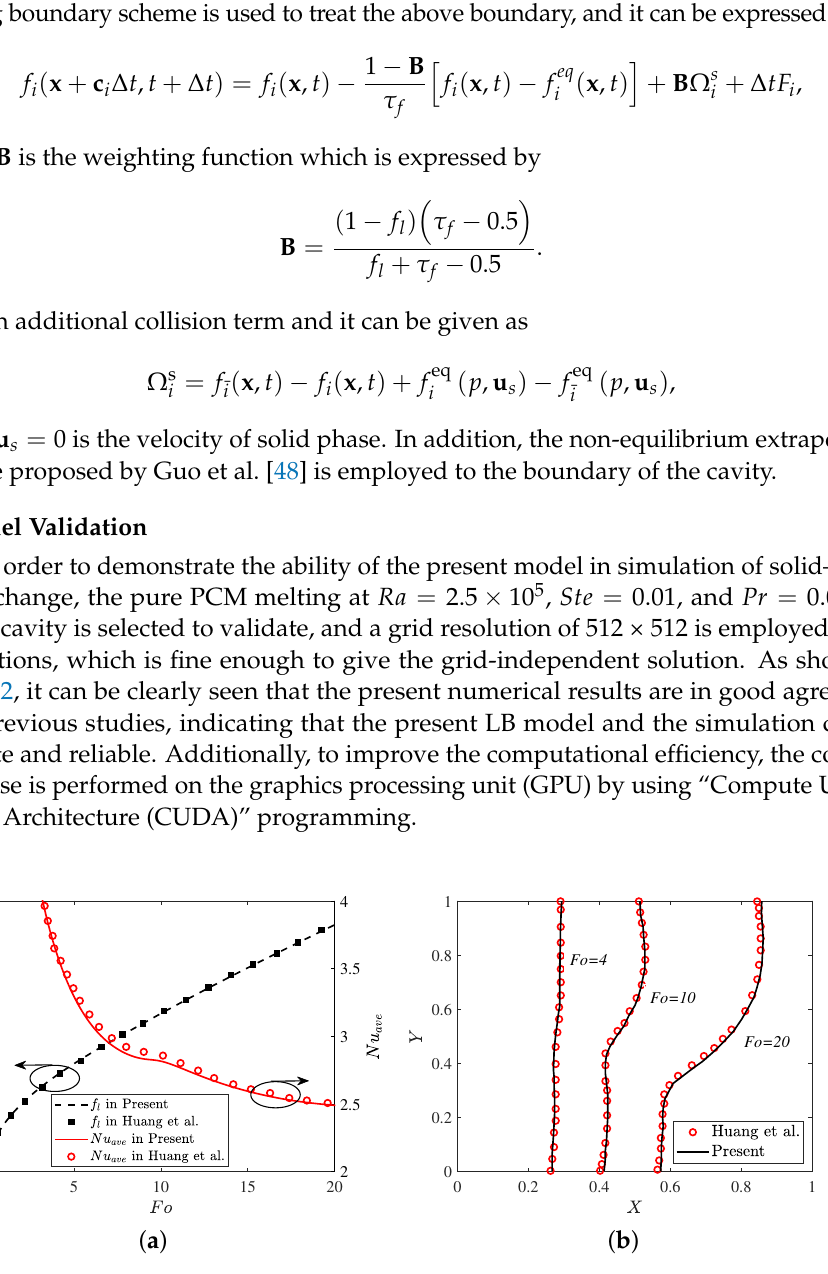
Figure 2. Comparisons of liquid fraction f l , average Nusselt number Nu ave ( a ) and phase interface position ( b ) between present numerical results and Huang et al.